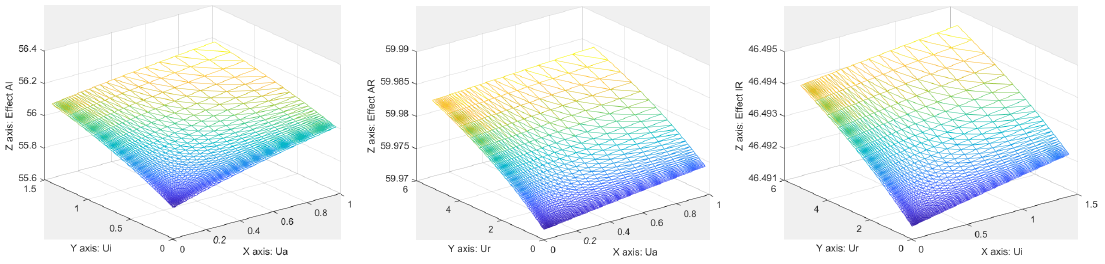
Figure A2. Surface responses obtained for σ = 1 for each drug combination.